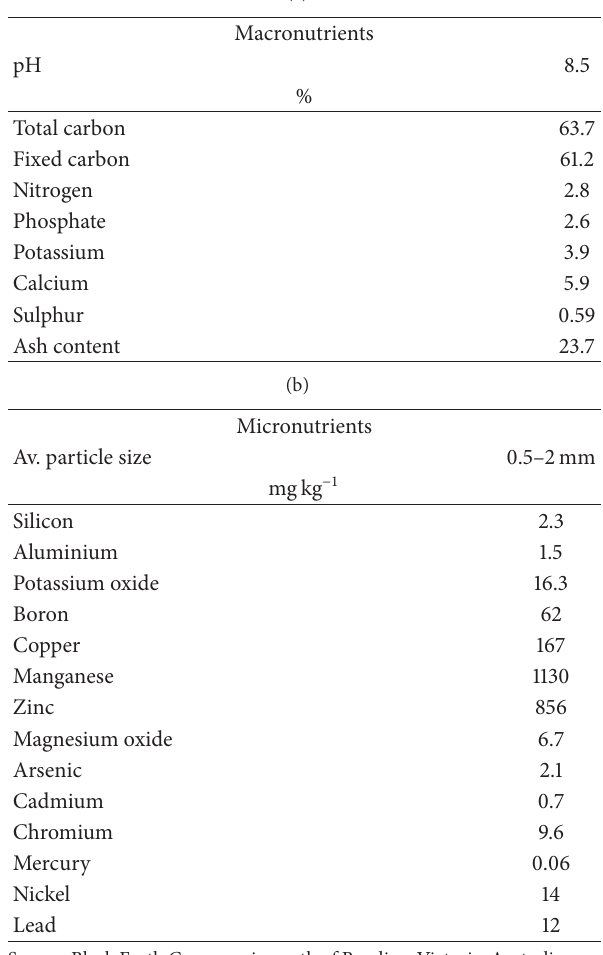
Table 1: Some selected chemical properties of Black Earth chicken litter